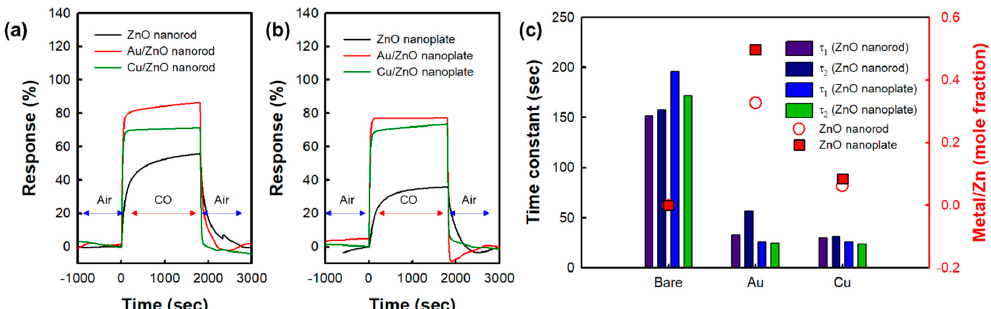
Figure 5. The actual response transient of pristine ZnO nanostructures and metal-deposited ZnO nanostructures to 100 ppm CO gas at 200 ◦ C. ( a ) ZnO nanorod and metal-deposited ZnO nanorods. ( b ) ZnO nanoplate and metal-deposited ZnO nanoplates. ( c ) Response and recovery time of pristine ZnO nanostructures and metal-deposited ZnO nanostructures. Table 3. The gas response, response time, and recovery time of the samples. Sample